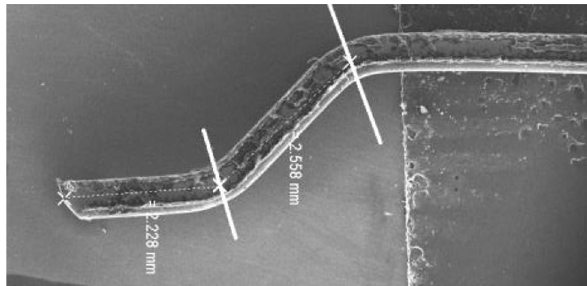
Fig. 2 SEM image shows measuring the hook